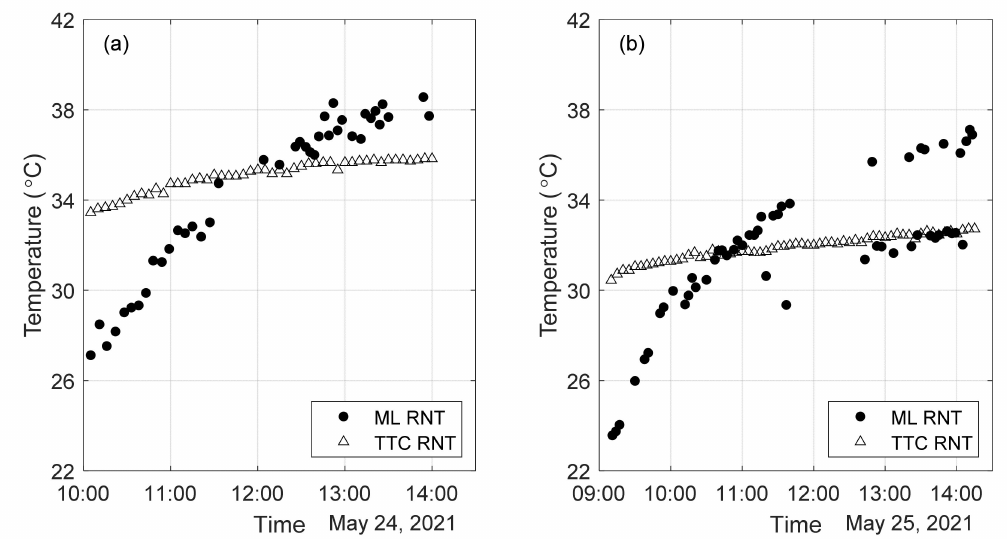
Figure 20. ML predictions based on the database obtained with the finite element analysis. The value of the predicted neutral temperature is overlapped to the independent estimation provided by TTC. ( a ) Results relative to Day 1; ( b ) Results relative to Day